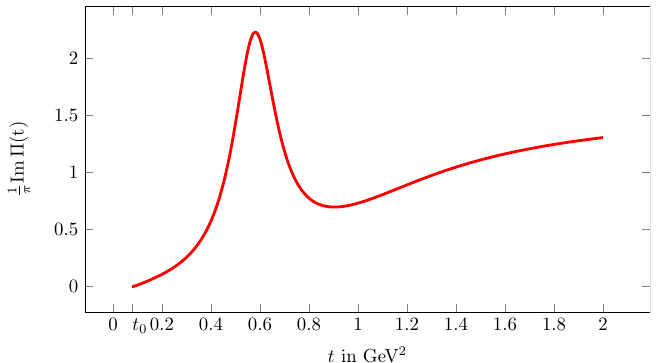
Figure 4 . The model spectral function in eq. (5.1) for t c = 1 GeV 2 and ∆ = 0 . 5 GeV 2 in α